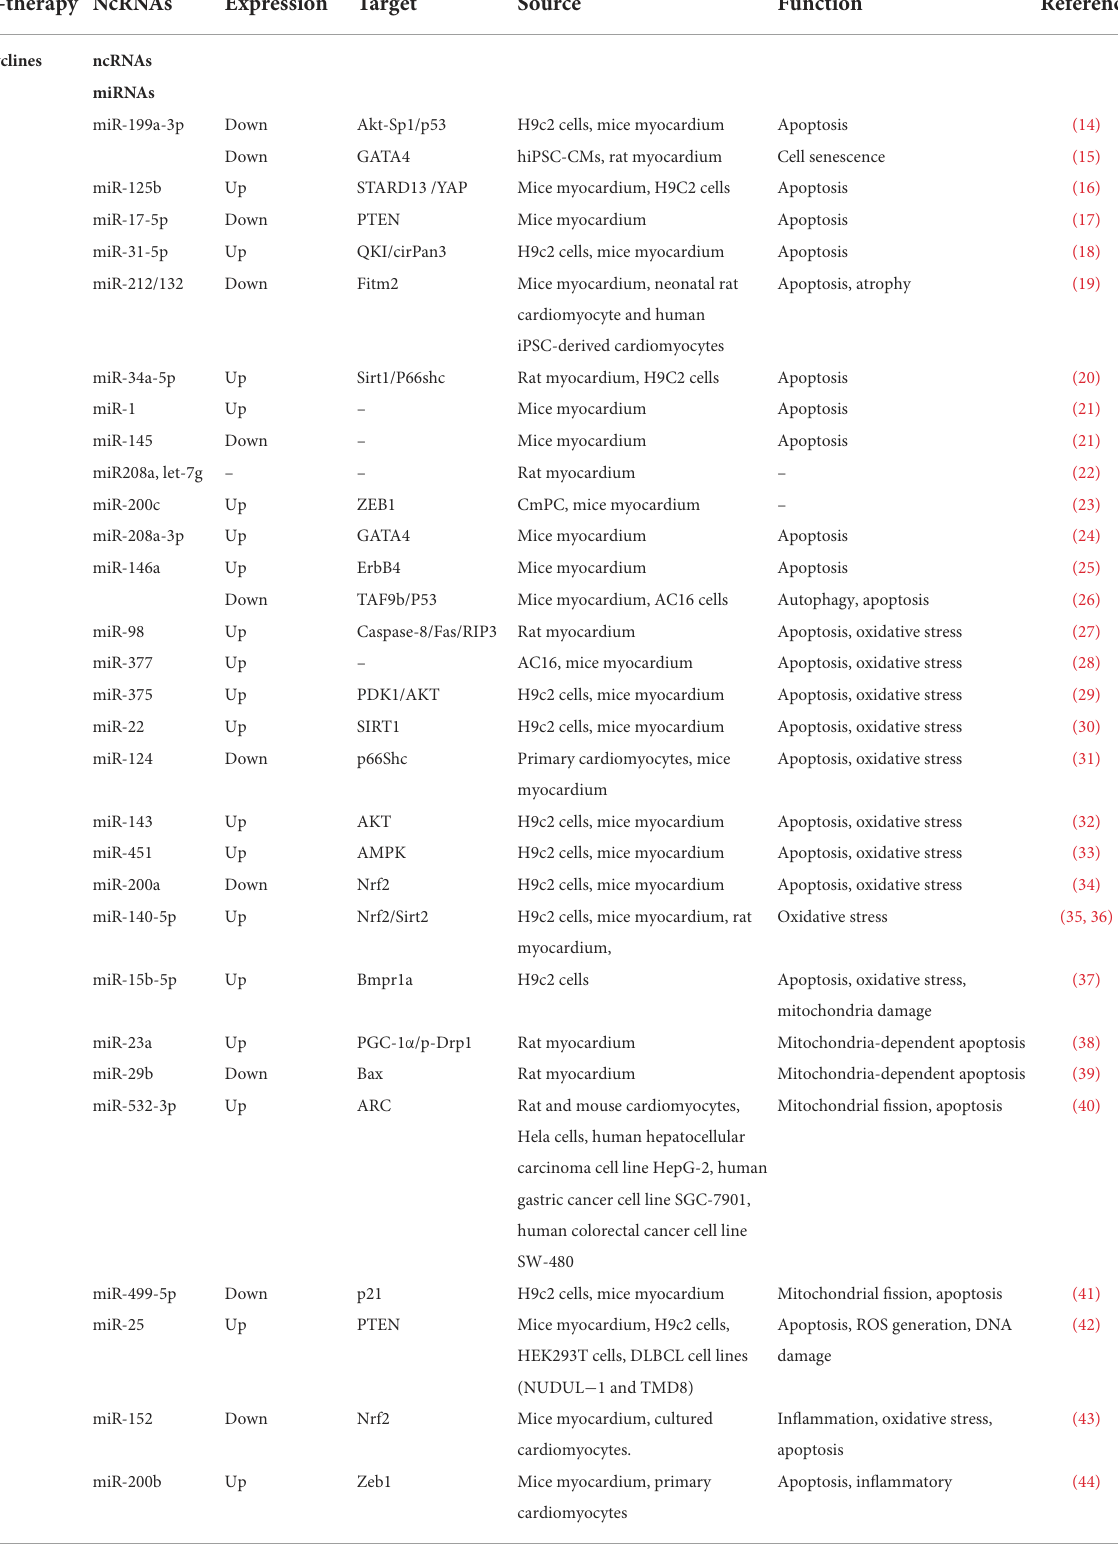
TABLE 1 ncRNAs in cancer therapy-induced cardiotoxicity. Cancer-therapy NcRNAs Expression Target Source Function